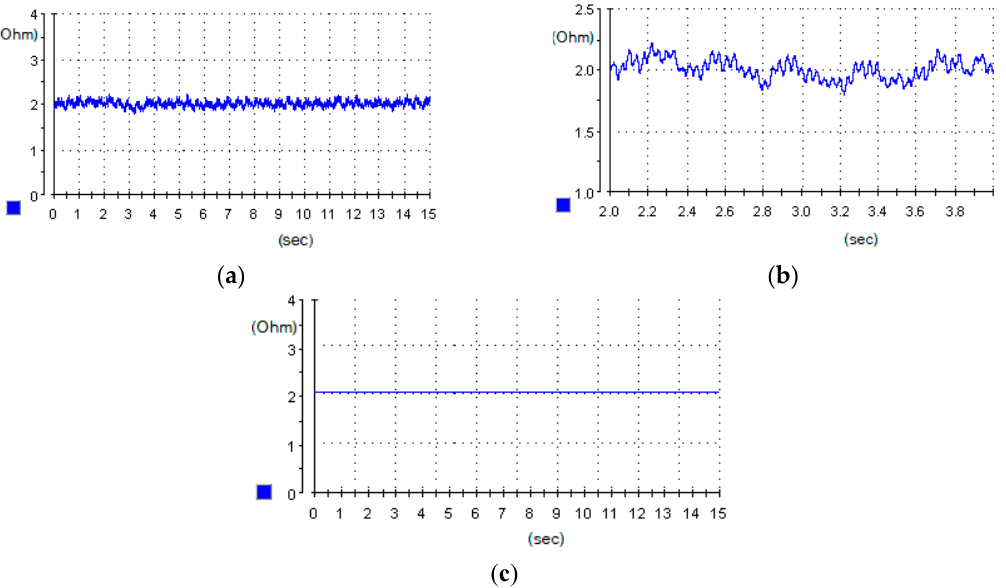
Figure 11. ( a ) Estimated rotor resistance with learning rate is constant; ( b) zoom of estimated rotor resistance with learning rate is constant; ( c ) estimated rotor resistance with learning rate as a function from Equation (11).